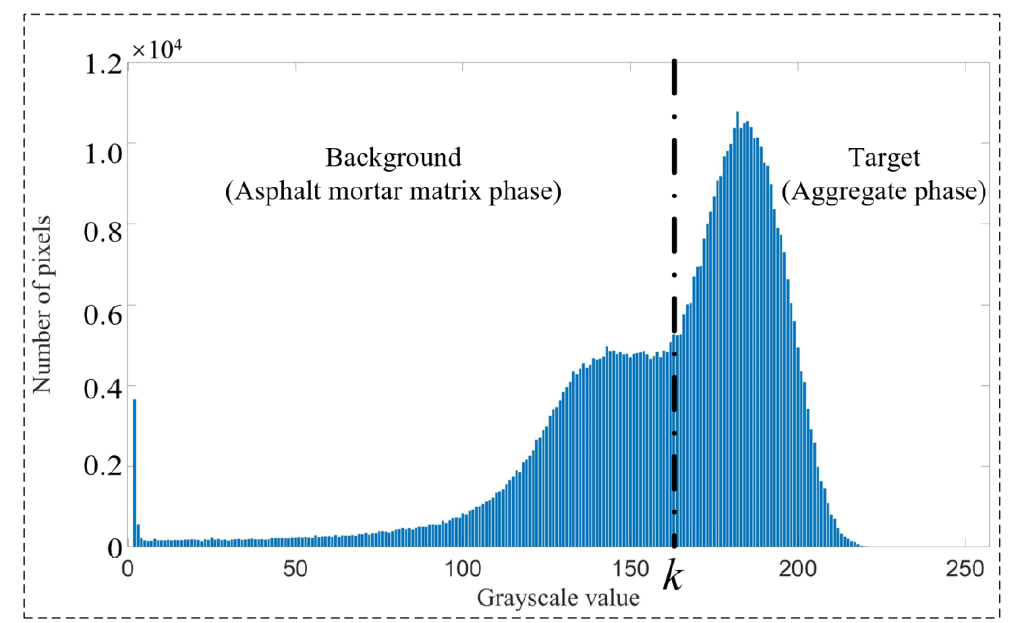
Figure 2. Schematic diagram of the OTSU method.